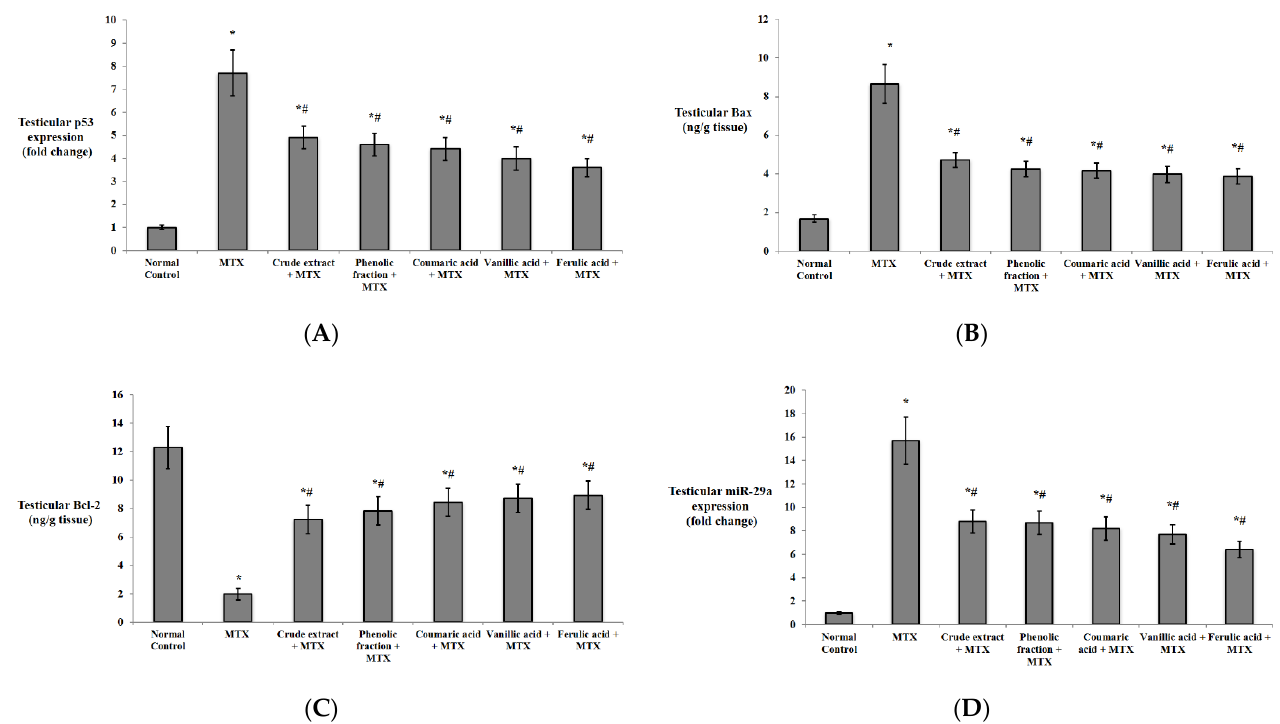
Figure 8. Effects of C. endivia L. crude extract, phenolic fraction, and its isolated compounds (coumaric, vanillic, and ferulic acids) on the testicular apoptosis biomarkers in the experimental mice. ( A ) p53 expression, ( B ) Bax levels, ( C ) Bcl-2 levels, and ( D ) miR-29a expression. Data are expressed as the mean ± SD. Data were analyzed using one-way ANOVA followed by Bonferroni’s post hoc test. * Significant against normal control group, # significant against MTX control group. Values were considered different significantly at p < 0.05. Bax: Bcl-2-associated X protein, Bcl-2: B-cell lymphoma.